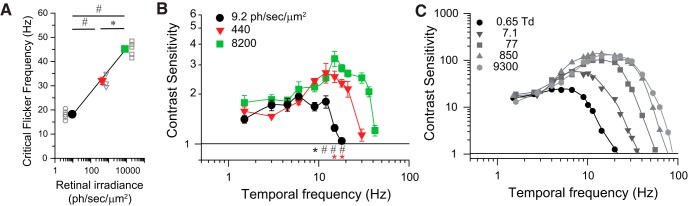
Mouse TCSFs have classic properties of human TCSFs. A, CFF increases with irradiance. Statistical analysis: RM ANOVA, significant differences between groups, #p < 0.001, *p < 0.05, with Bonferroni method. Symbols represent the average ± SEM (n = 3–5; for values, see Fig. 7-1). Linear fit represents predictions according to the Ferry–Porter law (see text for details). B, Comparison of average mouse TCSFs in Figure 6D–F at indicated irradiance levels. Statistical analysis: two-way RM ANOVA, #p < 0.001; *p < 0.05, comparisons for factor irradiance at 8200 vs 9.2 and 8200 vs 440 ph/s/μm2 are indicated with black and red symbols, respectively, using the Holm–Sidak method (see text for details). Symbols represent the average ± SEM (n = 5; for values, see Fig. 7-1). C, Human temporal contrast sensitivity functions adapted from Kelly (1961) illustrate the classic properties of adaptation to increasing illuminance levels (see text). Retinal illuminance levels for each function are indicated in Trolands (Td) and can be converted to equivalent rates of photoisomerization by applying the conversion relation previously established for primates wherein 1 Td = 11 R*/rod/s (Hood et al., 1999).